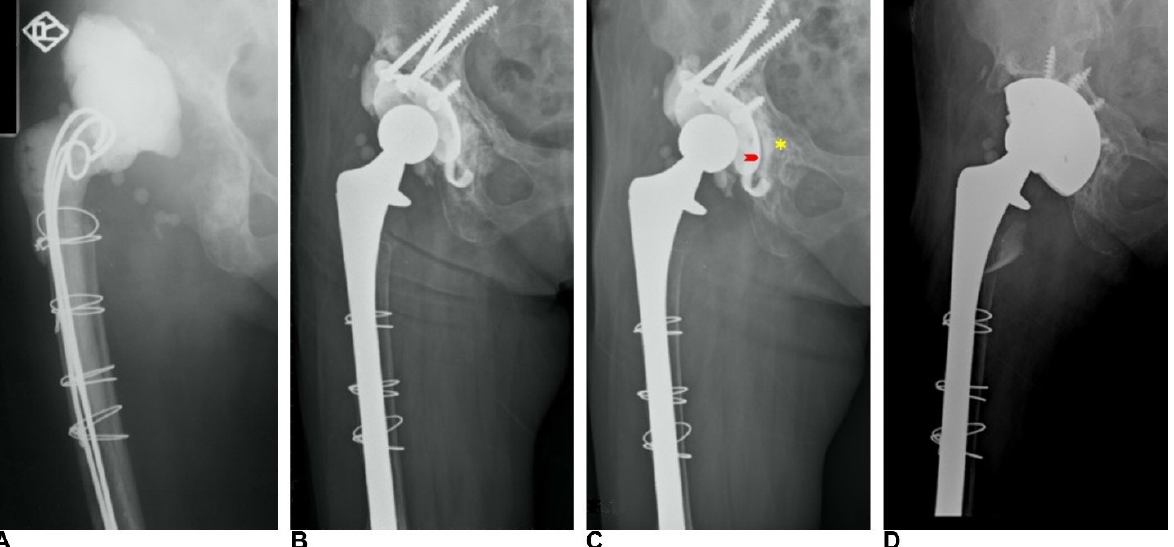
Figure 3. ( A ) Paprosky type IIIA acetabular bone defect after operation for periprosthetic joint infection. ( B ) Reconstruction of acetabulum bone loss with cage and bone allografts. ( C ) Cage failure eight years after index revision. Radiolucent line between cage and host bone (arrow), with union of the host bone and allografts (*) were shown. ( D ) The TM cup remained stable after nine years of follow-up after re-revision surgery.